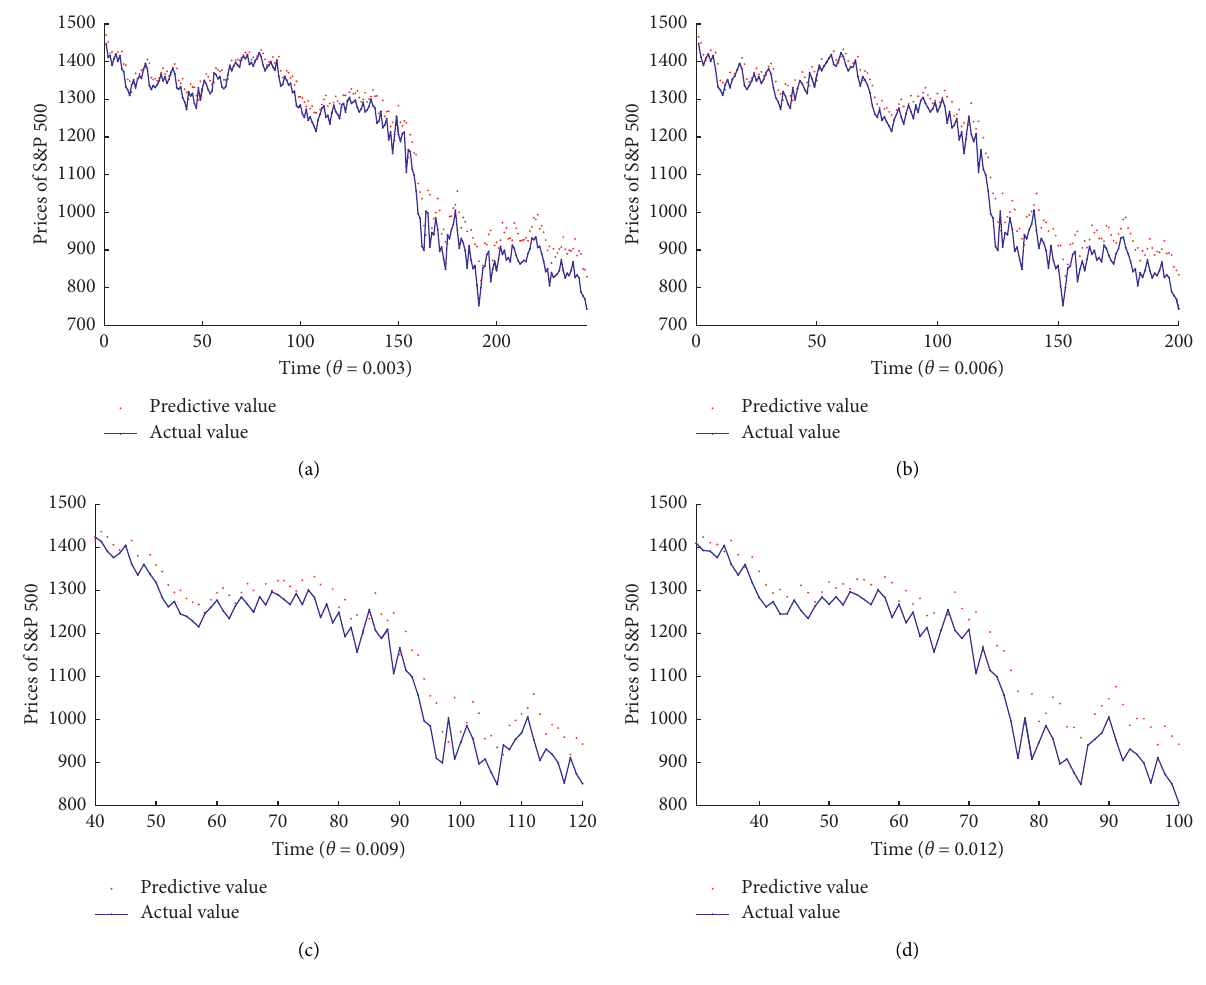
Figure 6: Volatility degree prediction of S&P 500 with different thresholds θ